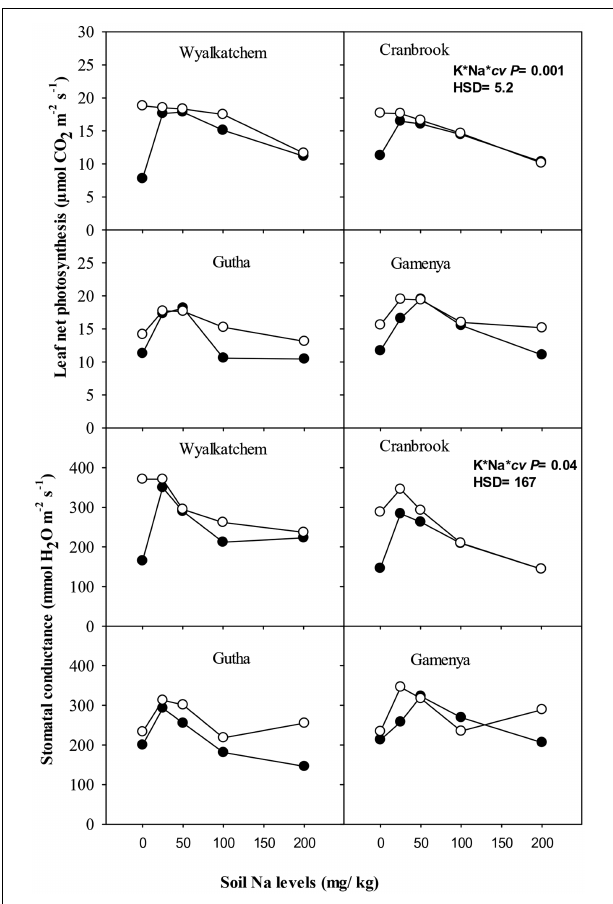
FIGURE 3 | Leaf photosynthesis (upper sub-figures) and stomatal conductance (upper sub-figures; n = 3) of four wheat cultivars, treated with 40 mg K/kg (closed circle) and 100 mg K/kg (open circle), and five soil Na levels (0, 25, 50, 100, and 200 mg Na/kg) for 8 weeks. See Table 1 for analysis of variance